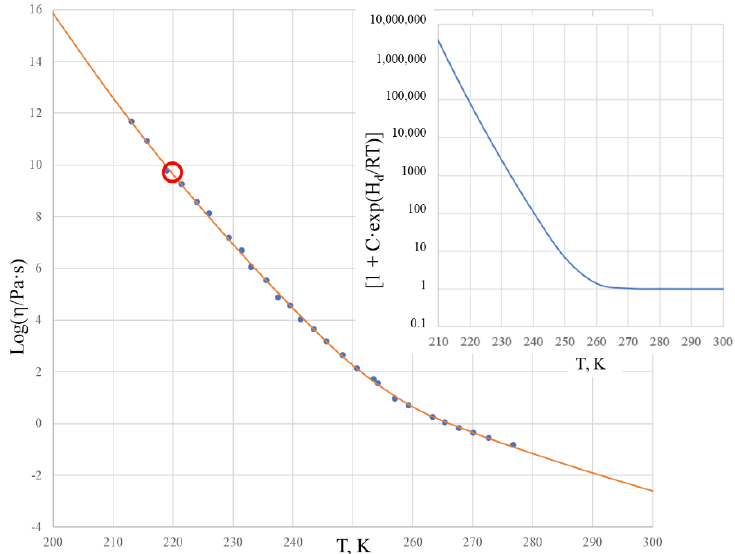
Figure 2. The viscosity of vitreous and molten salol. The theoretical curve was calculated using the two Sheffield equations (Equations (1) and (2)). Experimental data were taken from [33], with the red circle indicating the T g = 220 K [33]. The inset shows the temperature dependence of factor [1 + C · exp(H d / RT)] in Equations (1) and